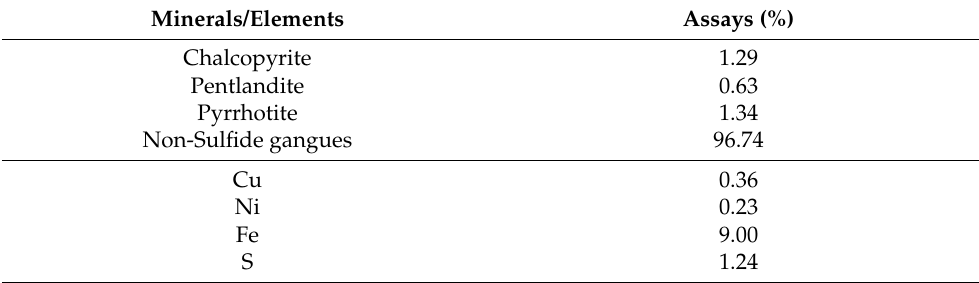
Table 1. Mineral and Chemical Assays in Kevitsa Ore.